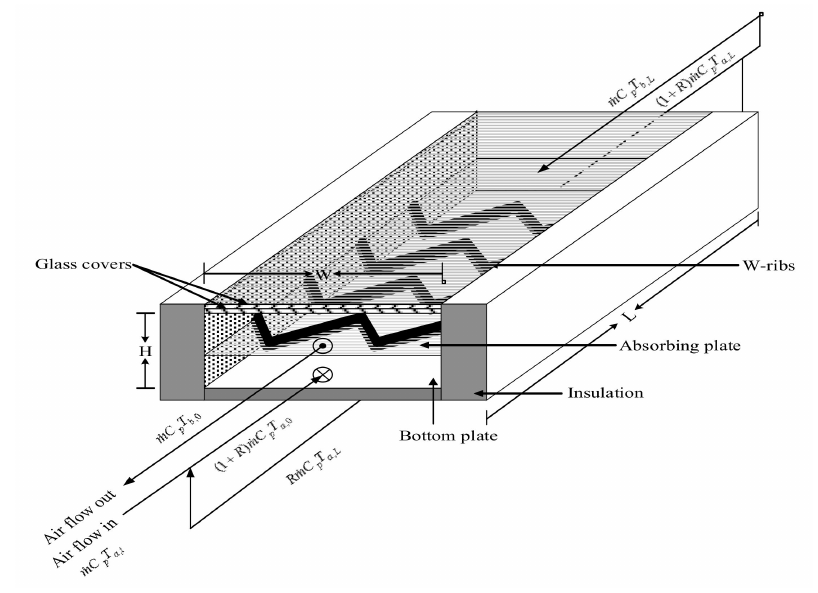
Figure 1. Schematic diagram of recycling double-pass W-ribs solar air